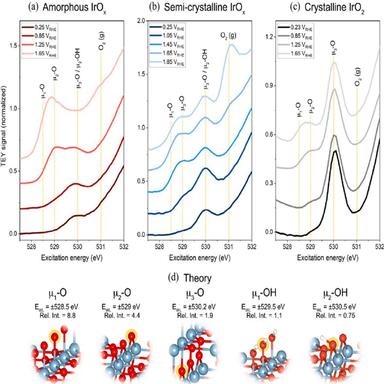
In-situ O K-edge spectra of graphene-covered IrOx films on Nafion during stepwise anodization. (a–c) Experimental spectra of amorphous, semicrystalline, and crystalline films, respectively, normalized to the edge jump at 550 eV. The spectra were recorded in 0.1 M H2SO4 using TEY detection mode, which has a probing depth of ~5 nm. The main contributing O(H) species in the spectra are indicated. (d) Theoretical analysis based on O K-edge simulations for various rutile IrO2 surface structures.